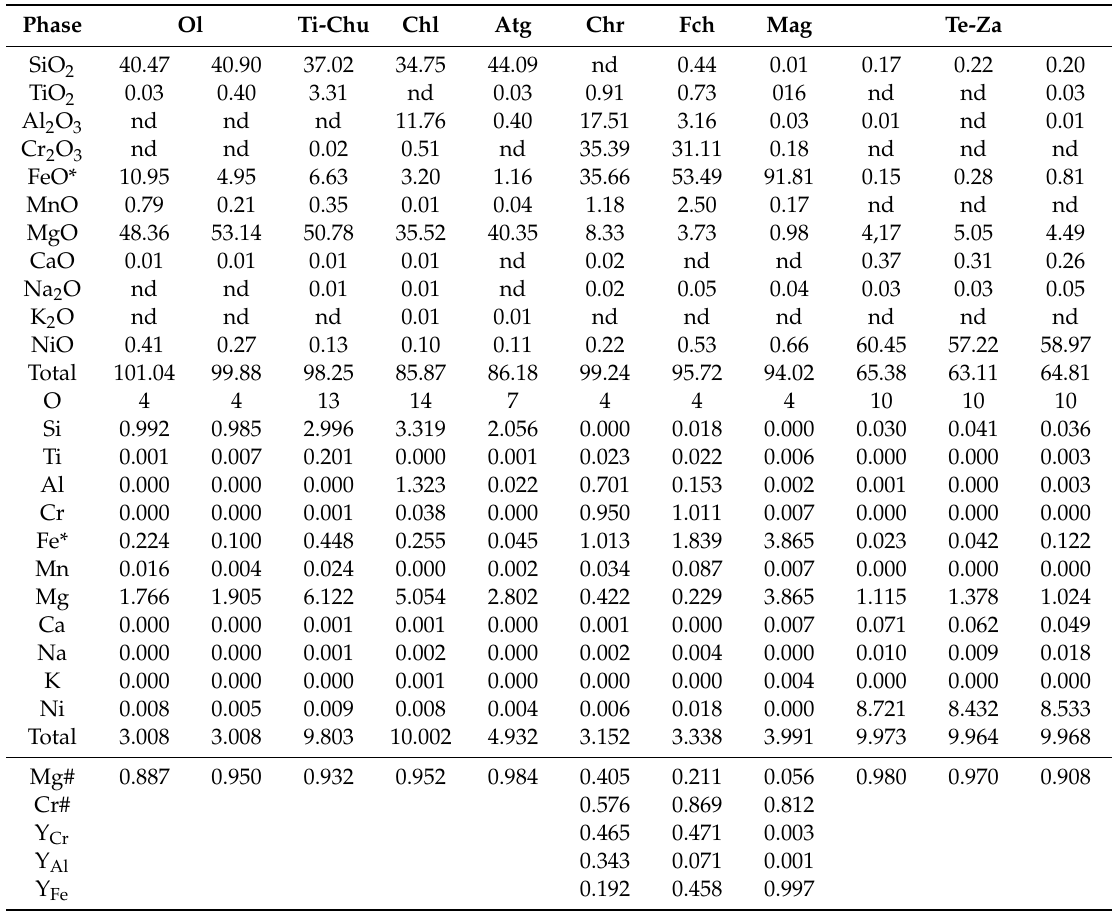
Selected microprobe analyses of minerals in the meta-dunite (T4-8) from Fujiwara, the Sanbagawa metamorphic belt, Southwest